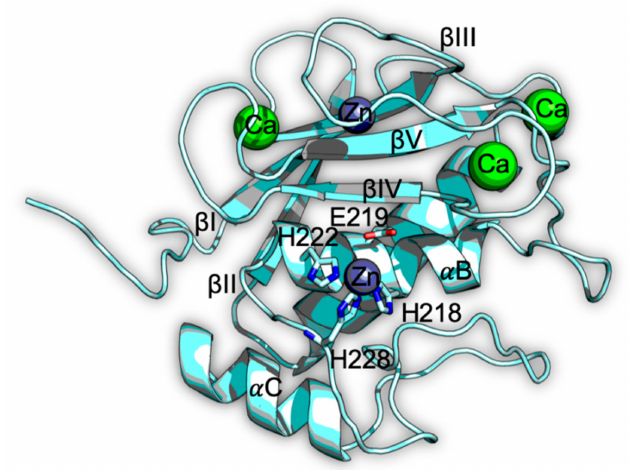
Figure 1. MMP Catalytic subunit. A cartoon representation of the MMP-1 (PDB code 1CGF) showing the di ff erent α -helixes and β -sheets with the corresponding coordinated metal ions. The sticks highlight the active site with the three histidines and the catalytic glutamic